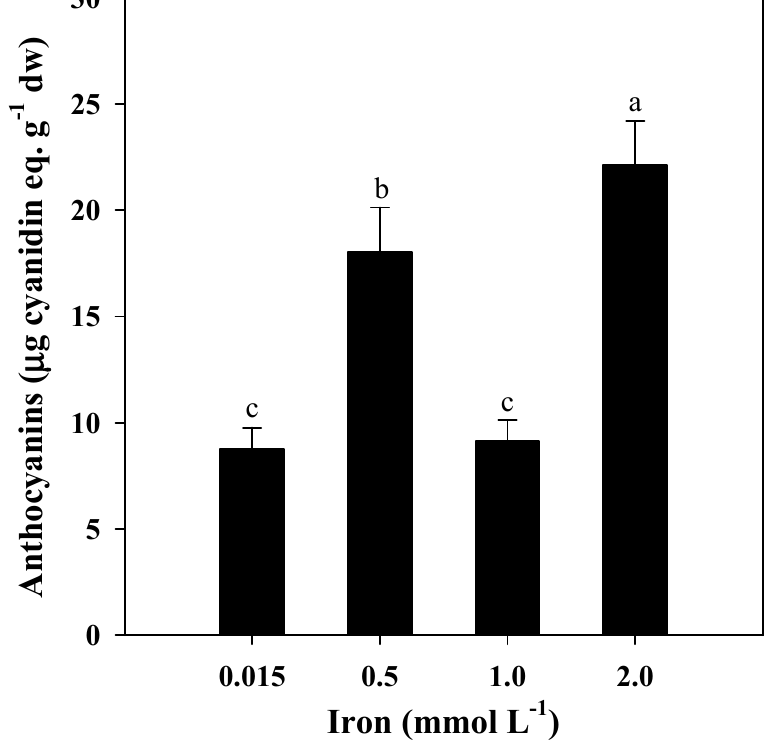
Figure 3. Effects of cultivar and iron concentration in the nutrient solution on anthocyanins content in red Salanova lettuce leaves. Anthocyanins in green Salanova were not detected. Different letters indicate significant differences according to Tukey’s HSD test ( P = 0.05). The values are means of three replicates. Vertical bars indicate ± standard deviation of means.